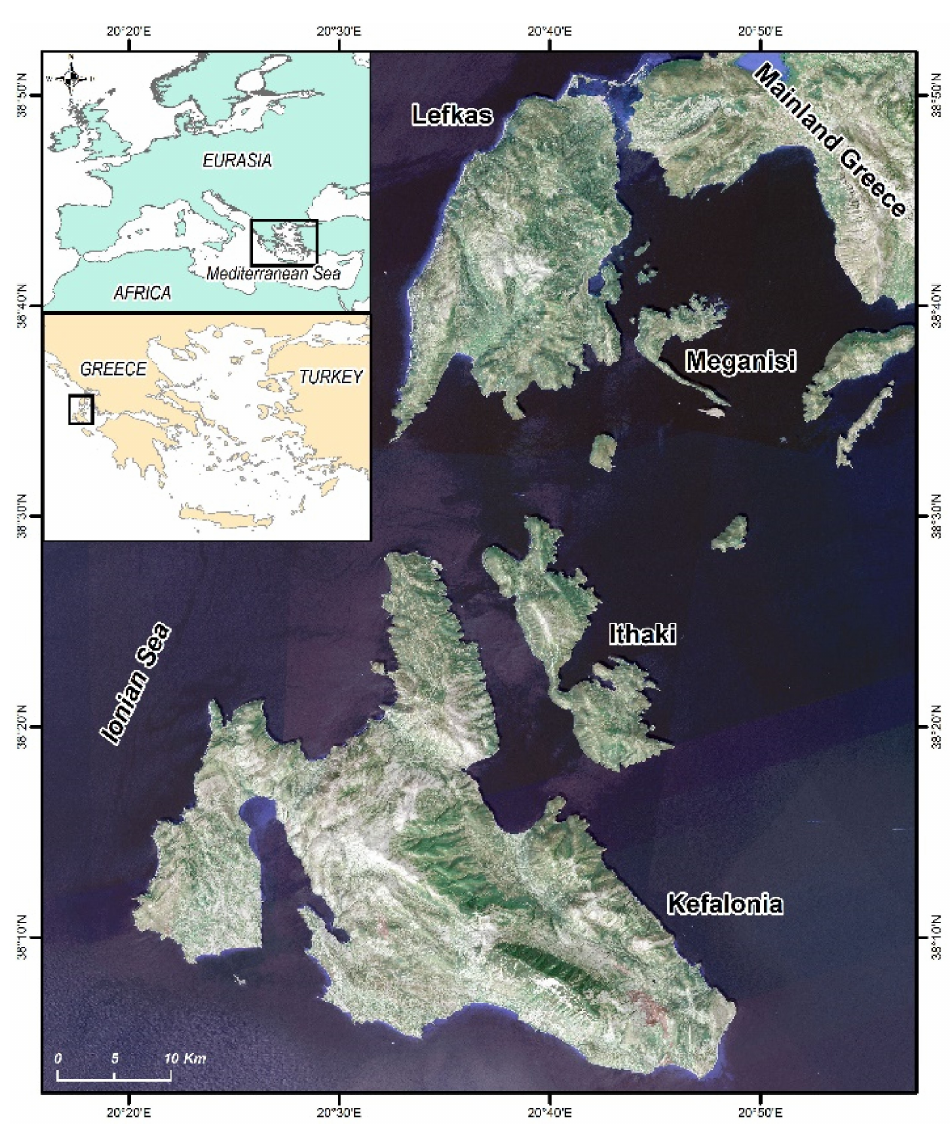
Figure 1. Map of the study area and location of the considered Ionian islands (Lefkas, Meganisi, Kefalonia,